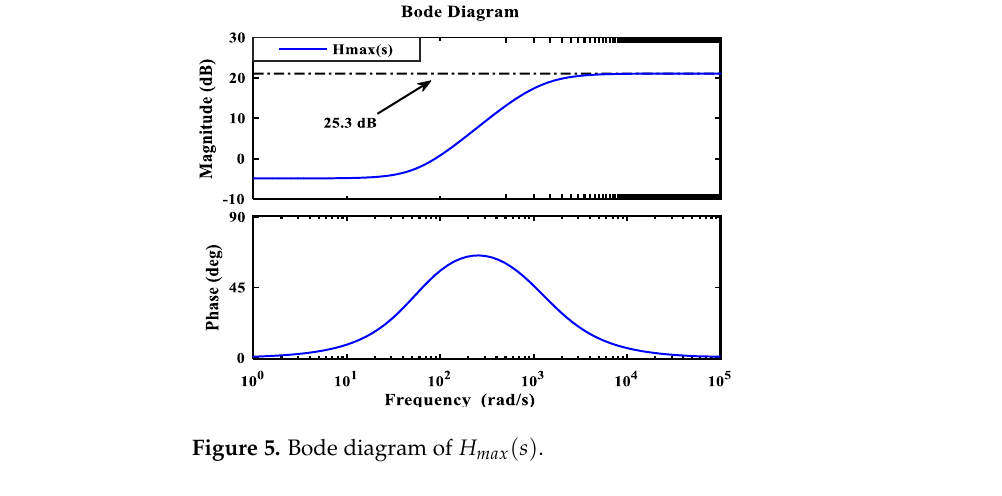
Figure 5. Bode diagram of H max ( s ) .